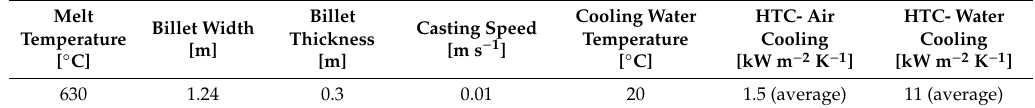
Table 1. Casting process parameters.